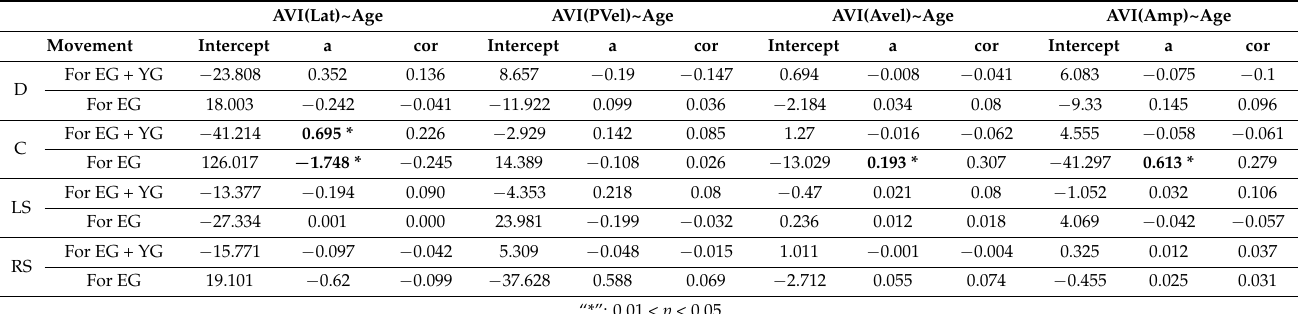
Table 3. Relationships between the AVI scores and age, from simple linear regressions